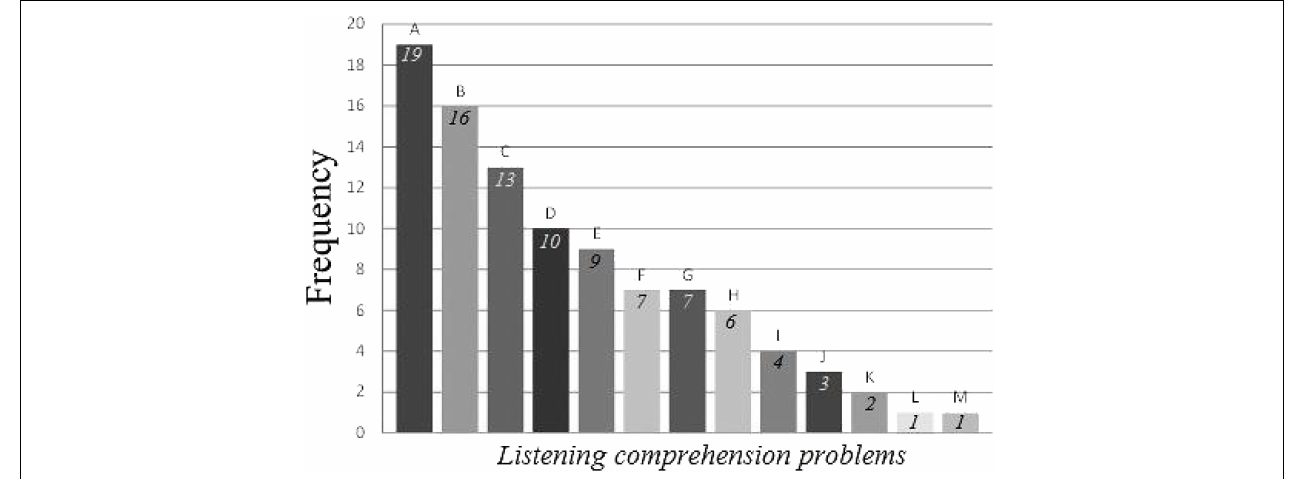
FIGURE 2 | Frequency of learners’ knowledge about the factors that influenced their listening comprehension. A. vocabulary , B. accent, C. prior knowledge and experience, D. speech rate, E. voice clarity, F. collaborative discussions, G. sentence length and complexity, H. interest and purpose, I. attention and concentration, J. visual support, K. accuracy of pronunciation, L. competence in speaking, M. type of